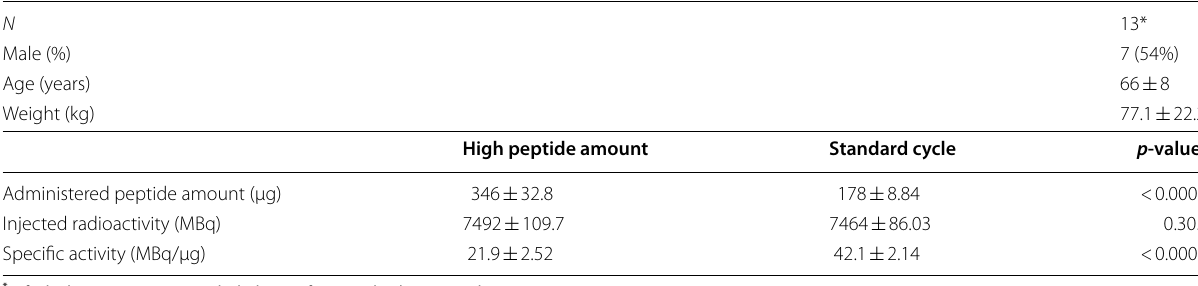
* Of which 2 patients were included twice for paired Wilcoxon analysis Continuous variables are shown as mean